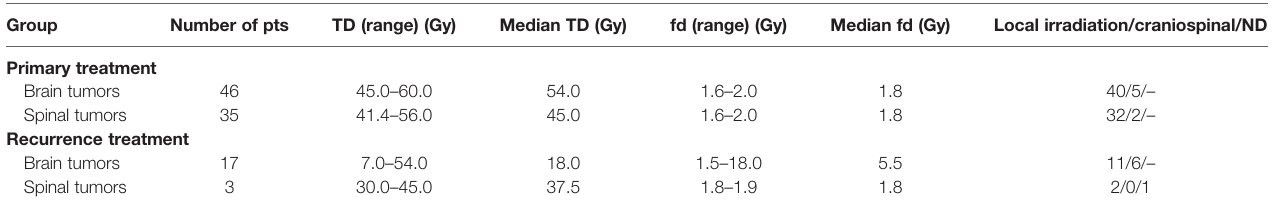
fd, fraction dose; Gy, grey; ND, no data; pts, patients; RT, radiotherapy; TD, total